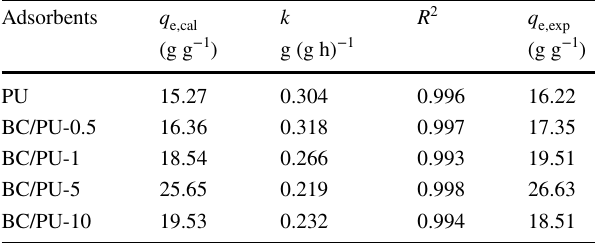
Fig. 6 Time-dependent OSs adsorption capacity (q t/q t versus t based on the pseudo-second order kinetics ( b ) of BC/PU foam composites in aqueous solutions (foam sample of 0.1 g, n-hex- ane concentration of 0.01 wt%, 30 ℃ , and pH 7.0) Table 3 Pseudo-second order kinetic parameters and experimental ultimate n-hexane adsorption capacities for BC/PU foam composites Adsorbents